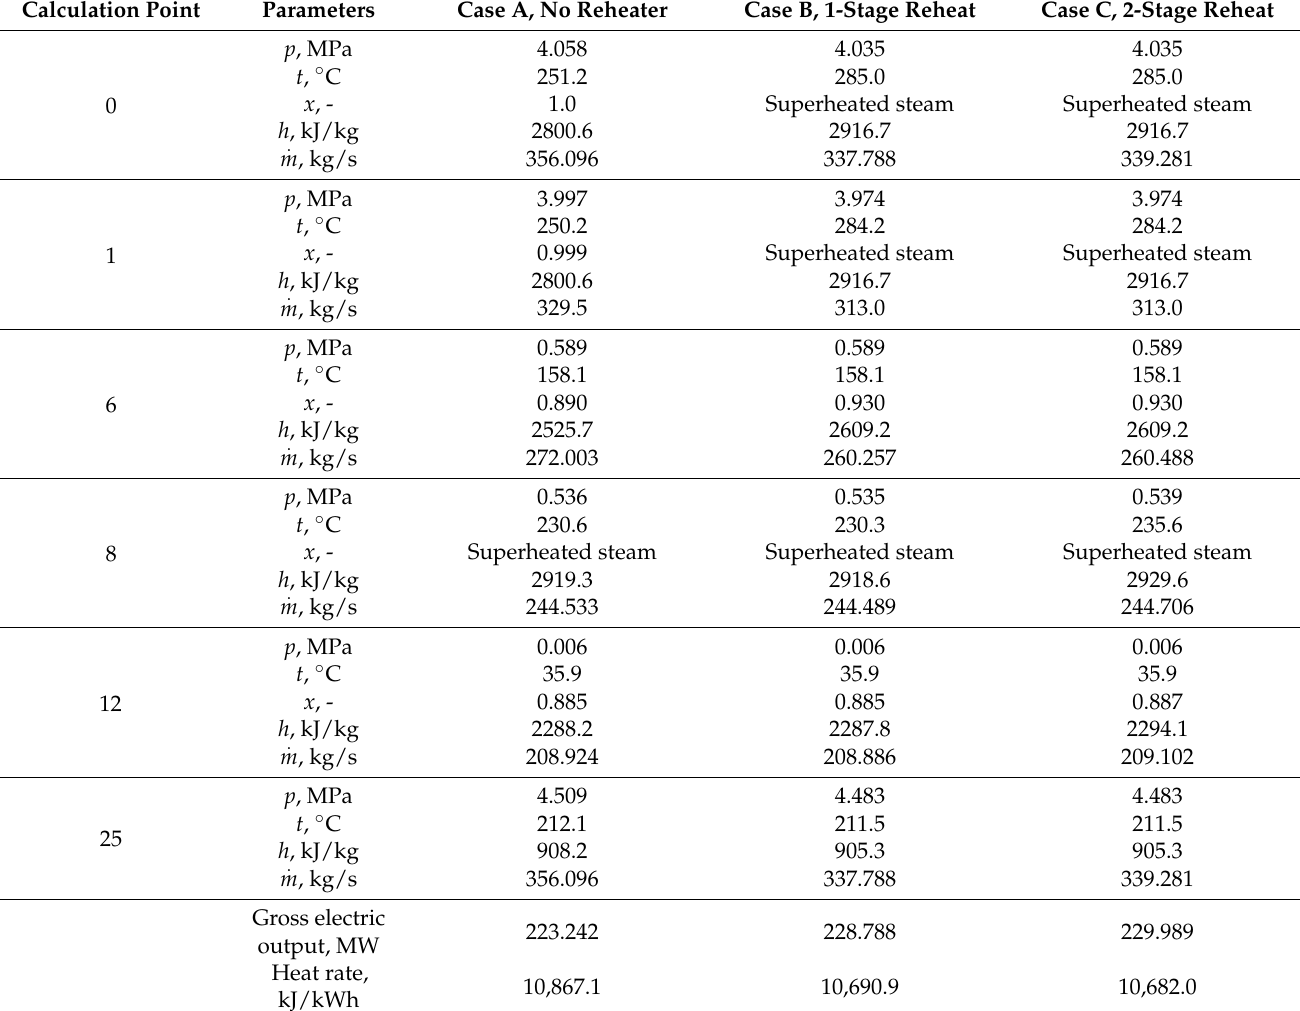
Table 2. Parameters at selected points in the cycle are presented in Figure